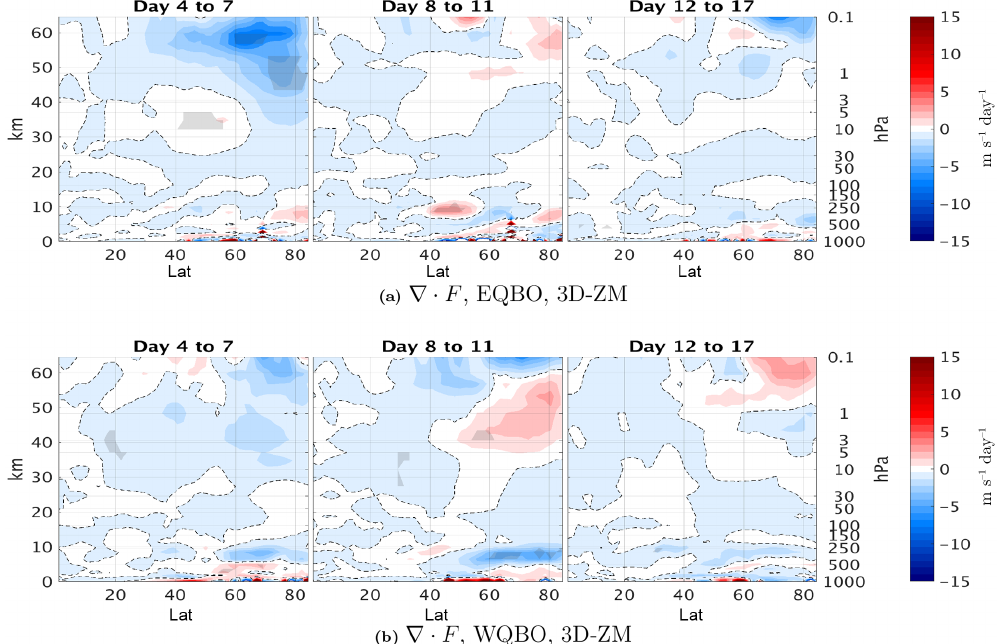
Figure 12. Latitude–height time lag composites differences of the 3DO 3 and ZMO 3 runs of the EP flux divergence (colors) for east QBO years (a) and west QBO years (b) for October events (70th percentile of V (cid:48) T (cid:48) at 100mb, 85–45 ◦ N). Dashed contours indicate negative values. Statistically significant areas are shown by gray